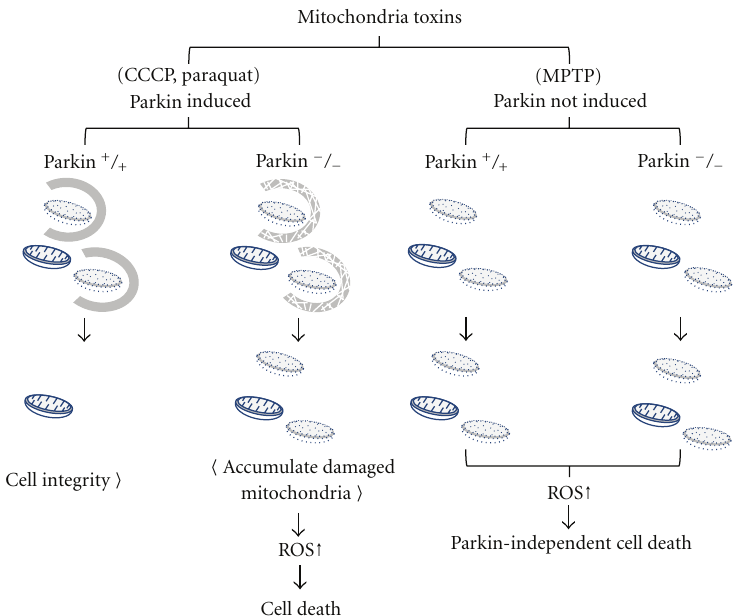
Figure 2: Two mechanisms of mitochondrial toxicity and parkin function. The e ff ect of mitochondrial toxicity is di ff erent between CCCP and MPTP. Treatment with CCCP recruits parkin to the mitochondria resulting in mitophagy to keep mitochondrial integrity. Parkin deficiency is associated with accumulation of damaged mitochondria and accelerated cell death. Treatment with MPTP does not necessarily induce parkin. Parkin may be the sensor of damage-adaptive